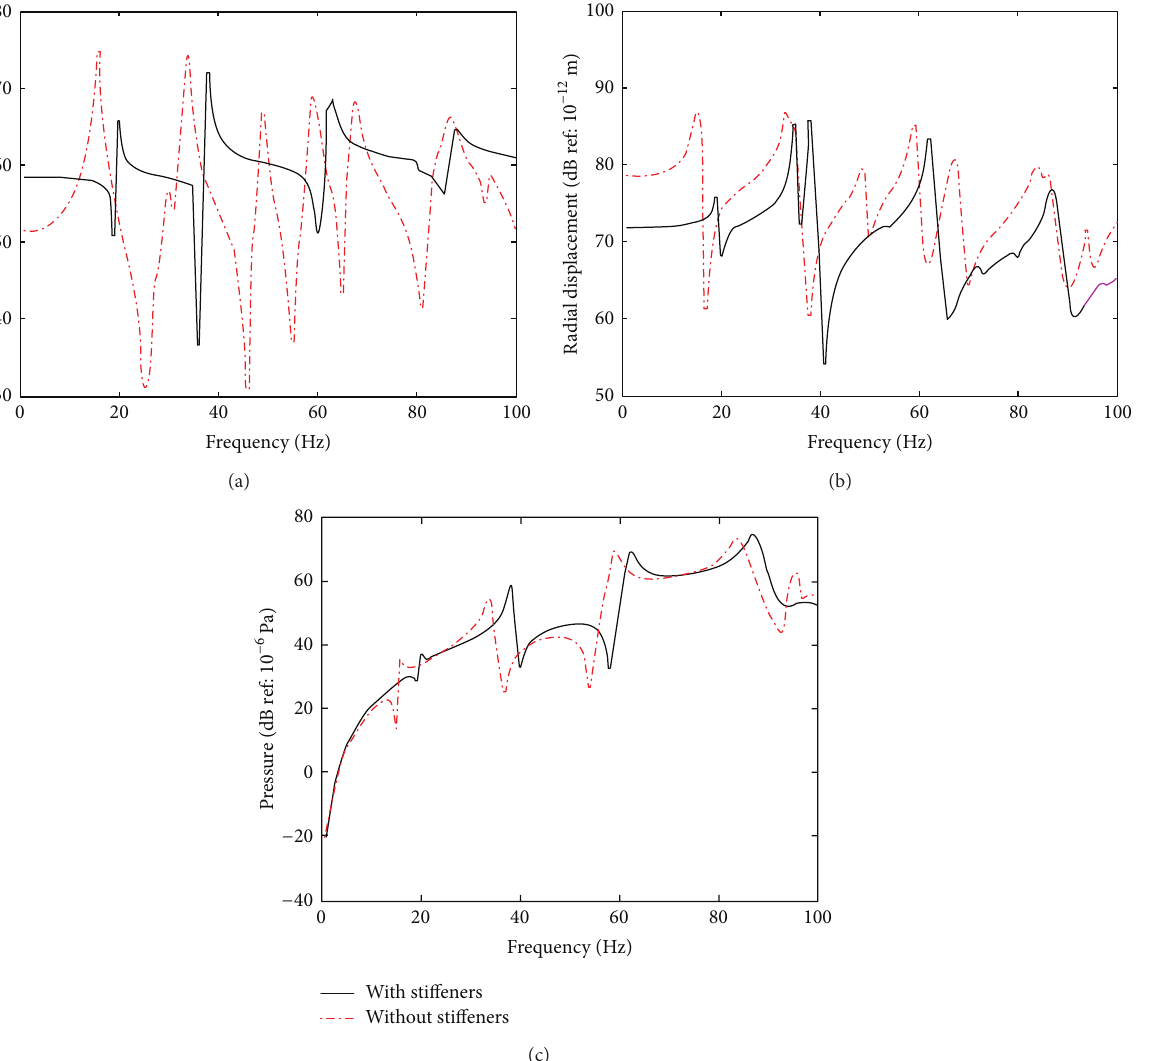
Figure 13: Comparison of conical shells with and without stiffeners, under 𝐹 1 (a) axial displacement, (b) radial displacement, and (c) far-field